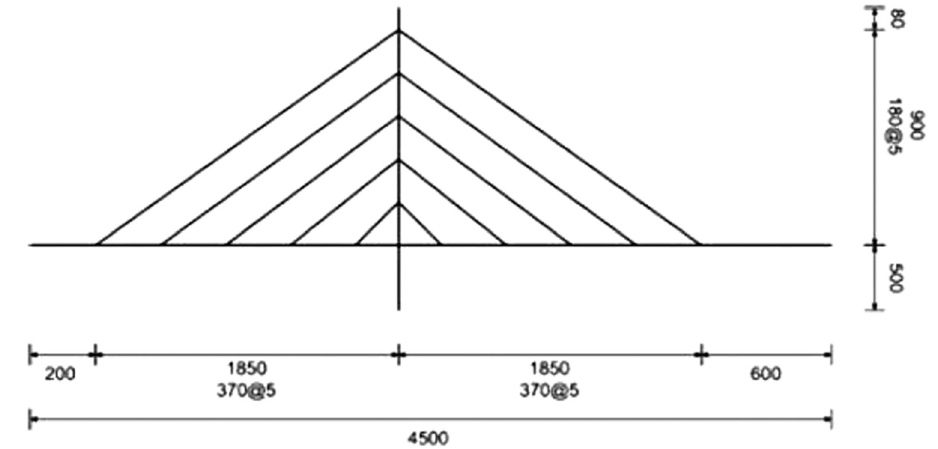
Figure 2: The geometrical con fi guration of the bridge